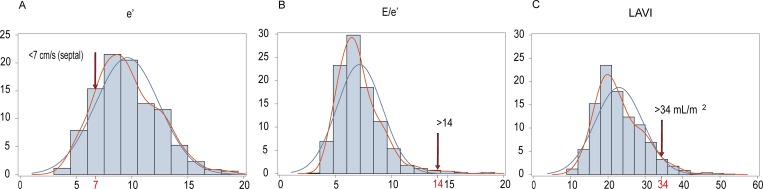
Distributions of: (A) the peak velocity of the mitral annular movement during early diastole (e’); (B) the ratio of the peak velocities of transmitral blood flow to mitral annular movement in early diastole; and (C) the left atrial volume index (LAVI). In line with the US guideline (J Am Soc Echocardiogr 2016;29:277–314), e’ was measured at septal wall in panel A, but was the average of the septal and lateral sample sites in panel B. Arrows indicate the cut-off values for diastolic LV dysfunction recommended for clinical use in patients with advanced diastolic dysfunction.